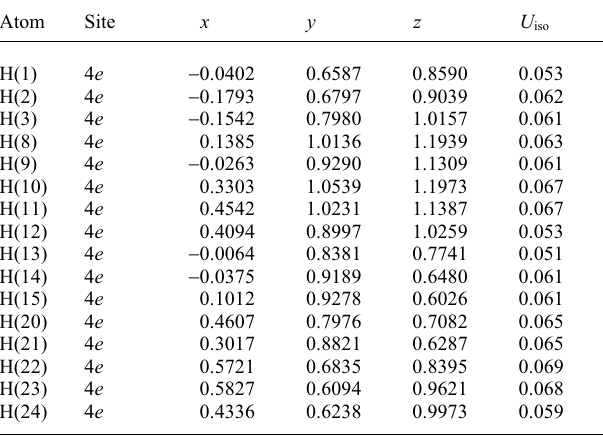
Table 2. Atomic coordinates and displacement parameters (in Å 2 )